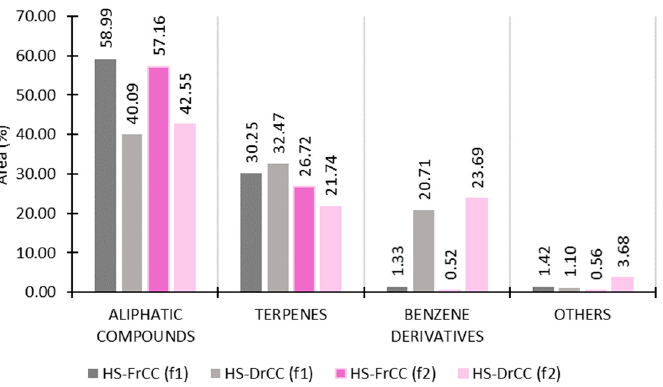
Figure 2. The VOCs of C. corniculata extracted by HS-SPME, analysed by GC-MS, and sorted by structural groups. HS-FrCC—headspace of fresh C. corniculata ; HS-DrCC—headspace of air-dried C. corniculata ; f1—DVB/CAR/PDMS fibre; f2—PDMS/DVB fibre.